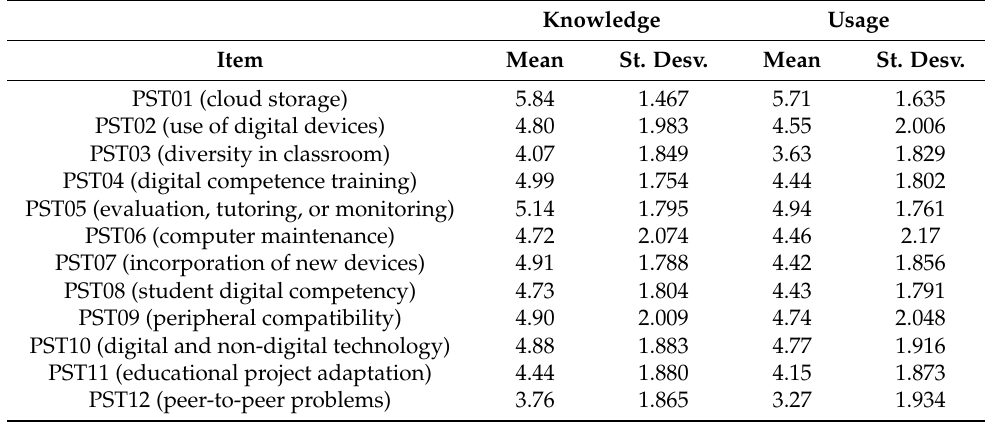
Table 5. Problem solving tools